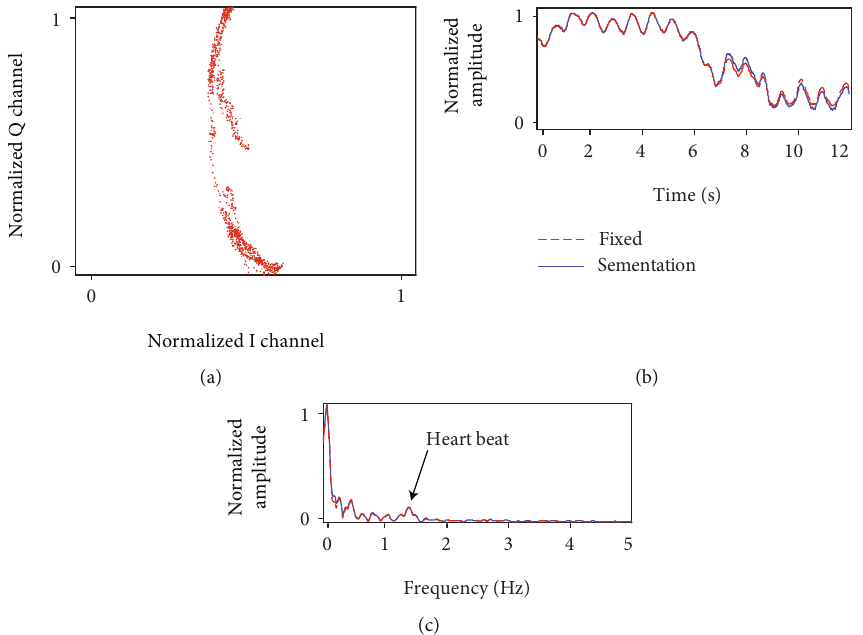
Figure 9: (a) I / Q constellation of biosignal when the subject tries to keep still. (b) Demodulation results in time domain by two methods: with segmentation or with fi xed DC o ff set. (c) Demodulation results in frequency domain by two methods: with segmentation or with fi xed DC o ff